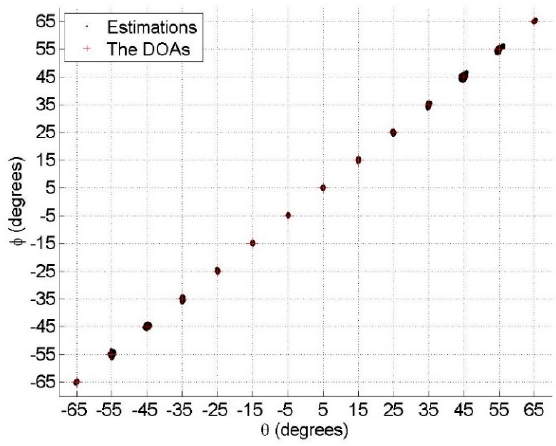
Figure 2. Estimations of 14 sources.